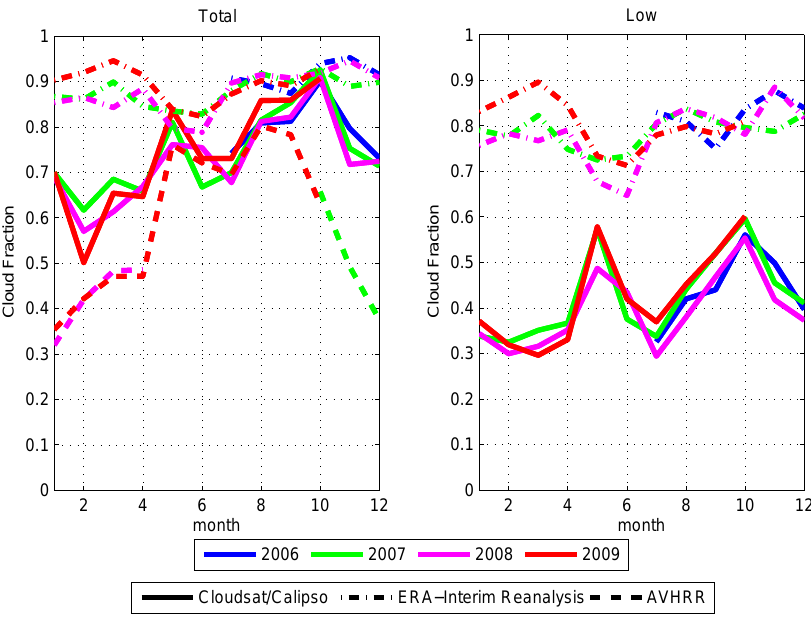
Fig. 2. Annual cycles of total- and low-level cloud fraction from 2006 to 2009 for the Arctic Ocean as derived from CloudSat/CALIPSO, ERA-Interim and an AVHRR-based retrieval from CM-SAF. For low-level clouds no data is available from